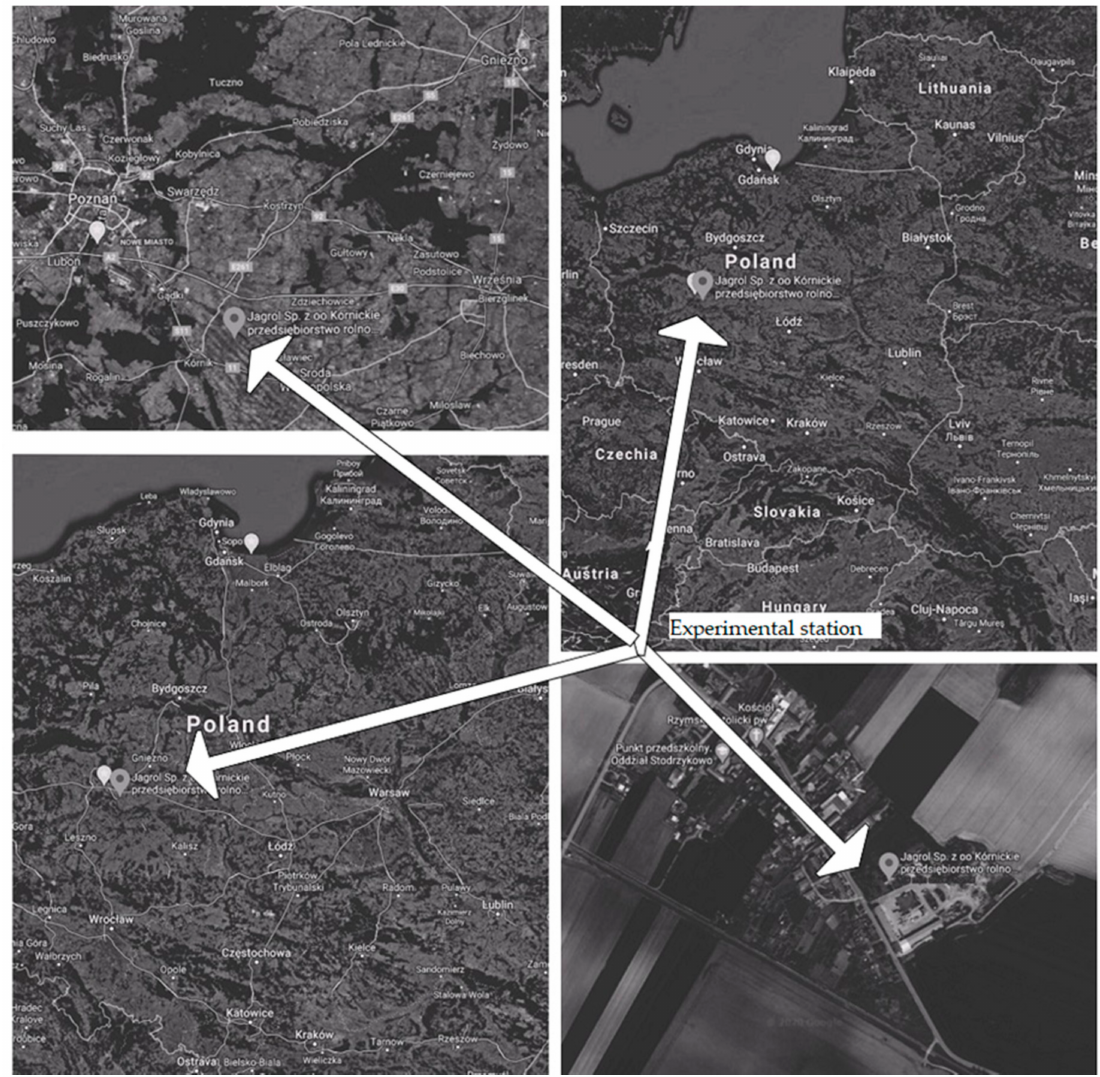
Figure 1. Geographical location of the study area in Pierzchno, Poland, source: google